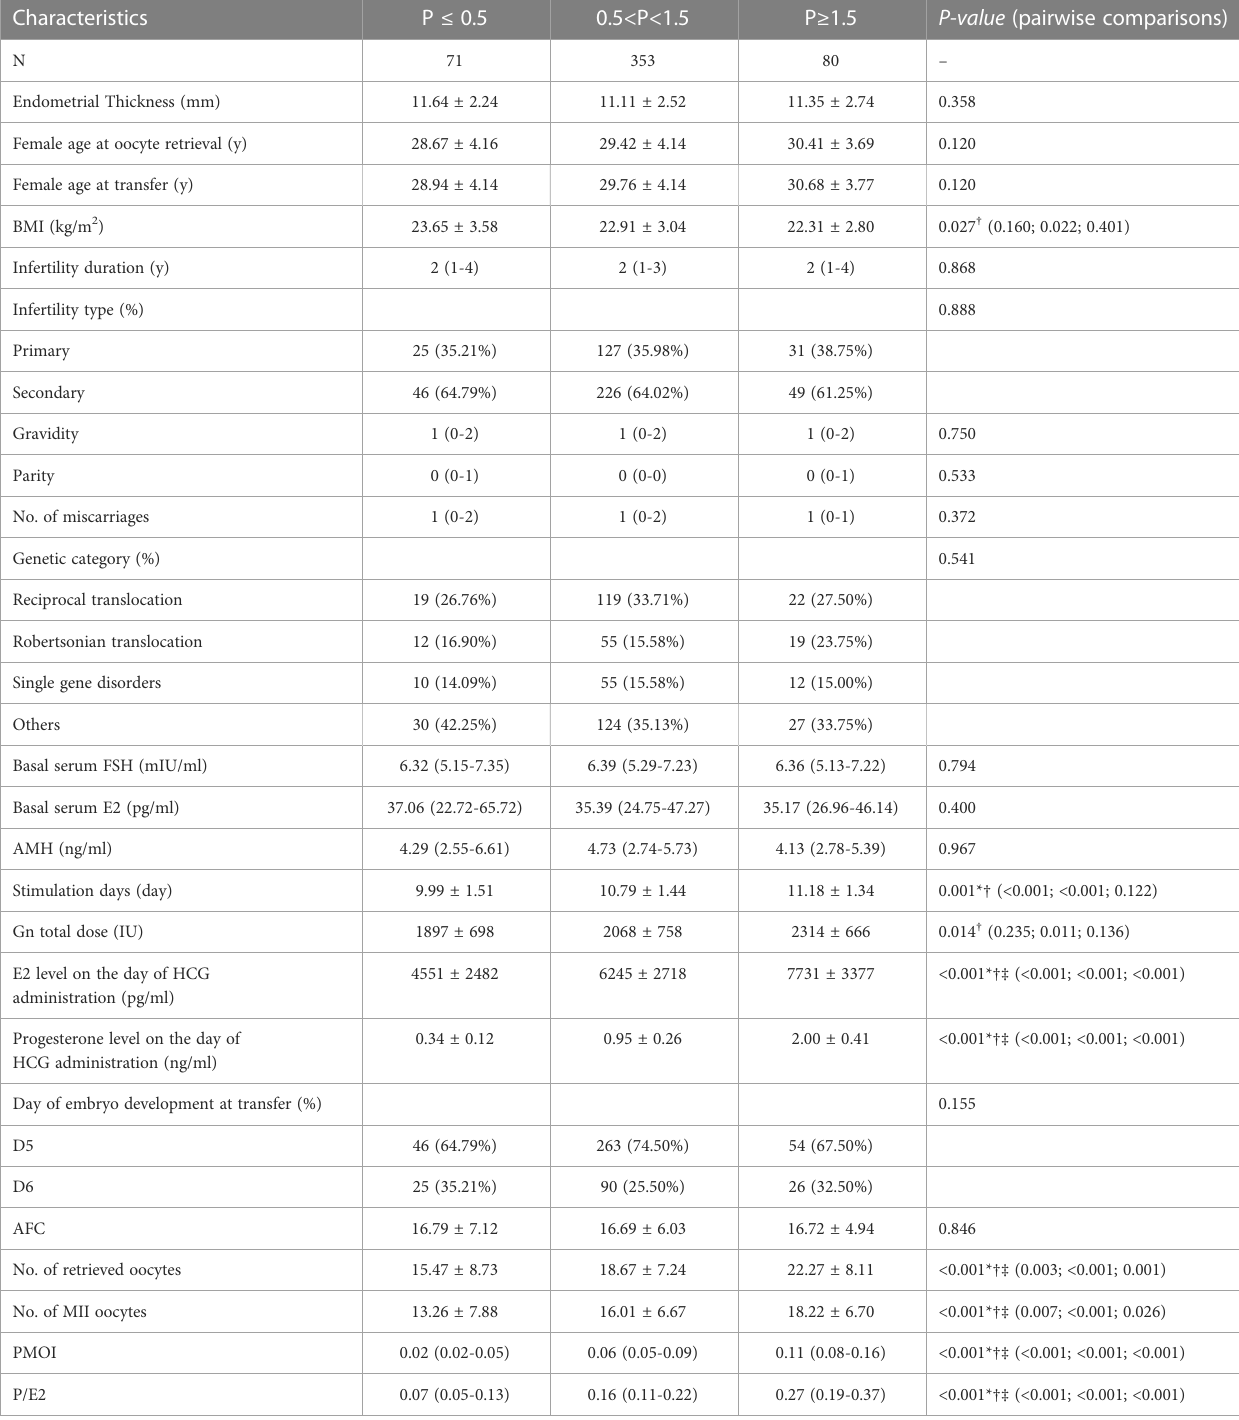
BMI, body mass index; Others: Other chromosomal genetic disorders include chromosomal deletions, inversions, insertions, chimerism; FSH, follicle-stimulating hormone; E2, estradiol; AMH, anti-Müllerian hormone; Gn, gonadotropin; HCG, human chorionic gonadotropin; AFC, antral follicle count; MII, metaphase II; PMOI, progesterone to mature oocytes index; P/E2, progesterone-to-estradiol ratio. P < 0.05 for the following pairwise comparisons: * ≤ 0.50 vs 0.51 – 1.49, † ≤ 0.50 vs ≥ 1.50 or ‡ 0.51 – 1.49 vs ≥ medium-P (64.79% vs. 49.01%, P =0.019) and high-P groups vs. 80.17% vs. 79.07%) and top-quality blastocyst rate (8.71% vs. (64.79% vs. 41.25%, P =0.005), albeit the difference between the 8.24% vs. 7.94%) decreased with increasing P, although there were medium- and high-P groups was not signi fi cant ( P >0.05). The no signi fi cant differences between groups ( P >0.05). Regarding the difference in live birth rate between the low- and high-P groups pregnancy rates of the different subgroups, the clinical pregnancy was also signi fi cant (54.93% vs. 35.00%, P =0.021), but that between rate was signi fi cantly higher in the low-P group than in the